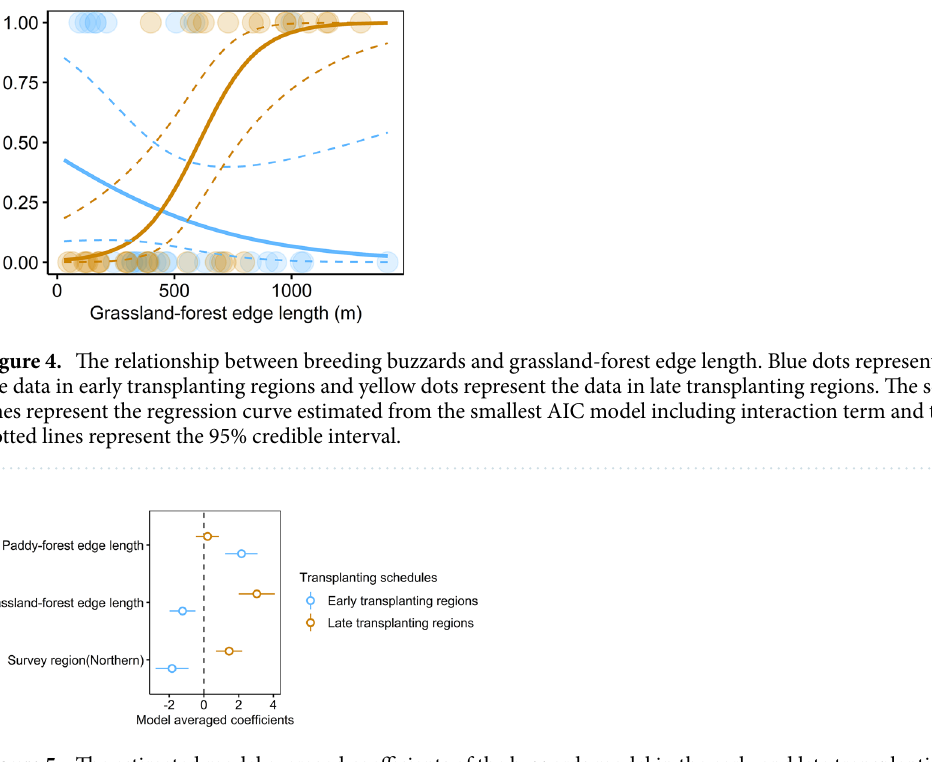
Figure 5. The estimated model averaged coefficients of the buzzards model in the early and late transplanting regions. Error bars represent standard errors.